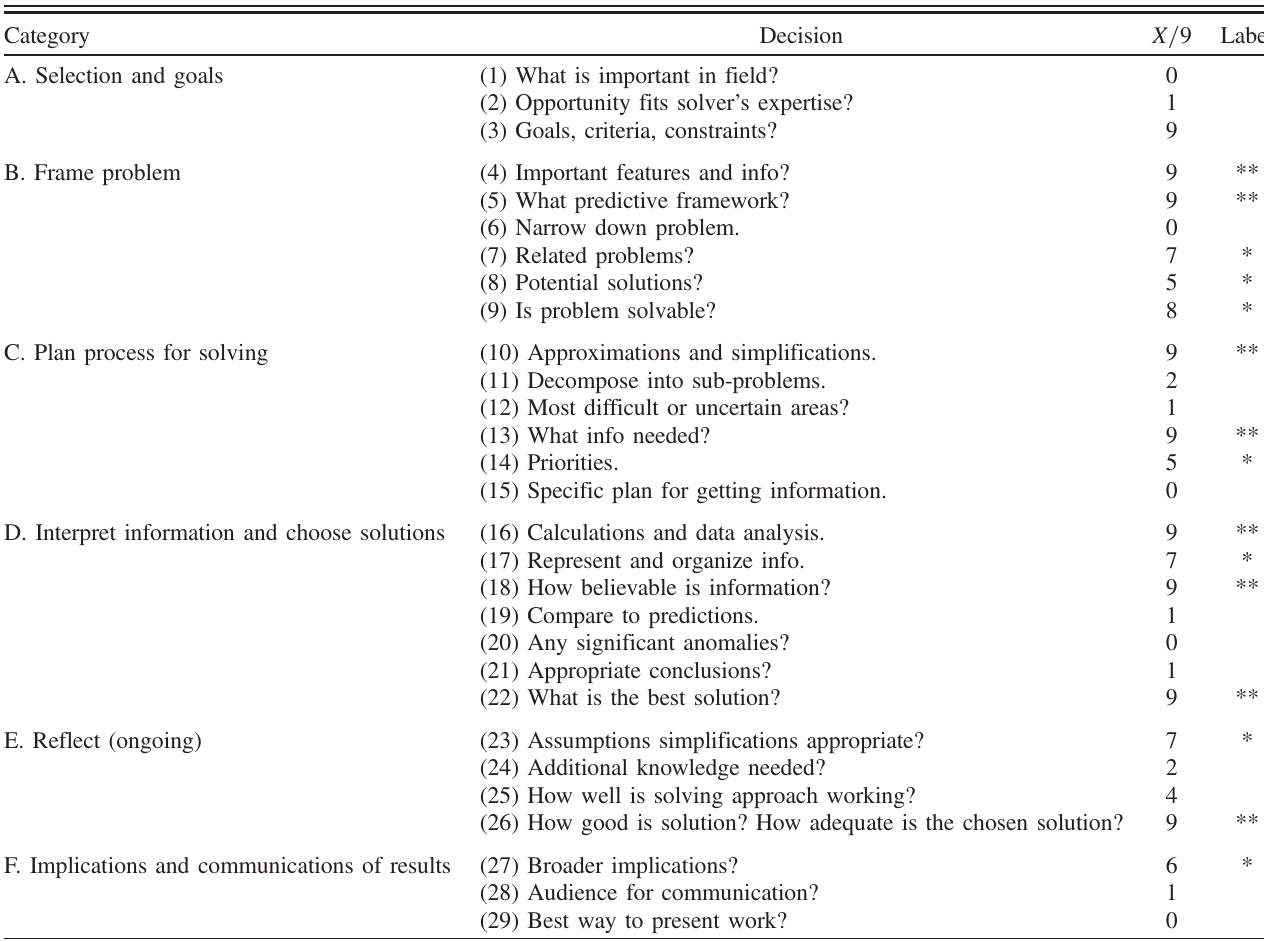
TABLE III. Decisions made by 8 = 9 or more physicists are labeled by two asterisks (**). Decisions made by 5 = 9 or more are labeled by one asterisk